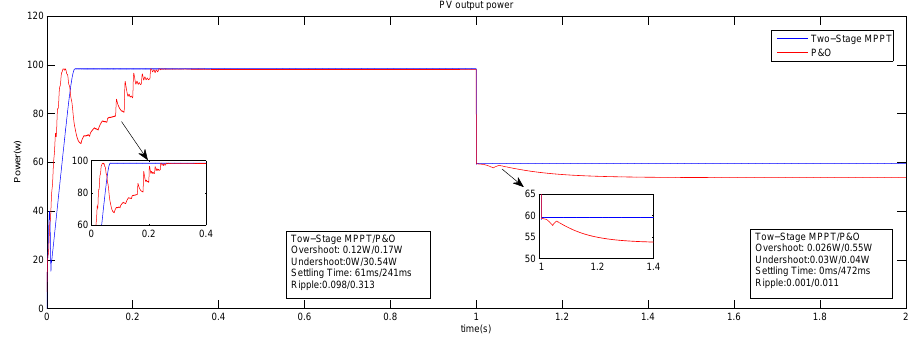
Figure 7. PV output power under irradiance